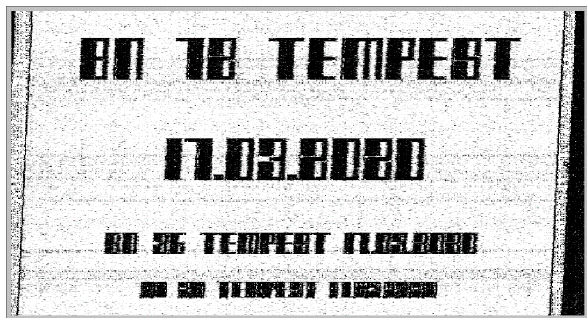
Figure 21. Size 72, 36, 28 without blank spaces: secure asymmetrical font.